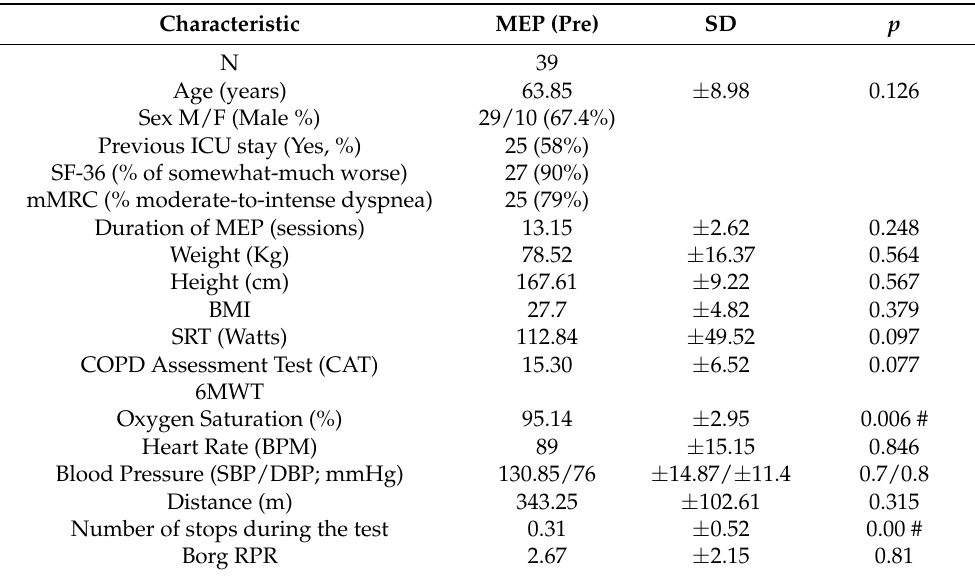
Table 1. Baseline patient characteristics. Values are means ± standard deviation (95% confidence interval). p < 0.05 is statistically